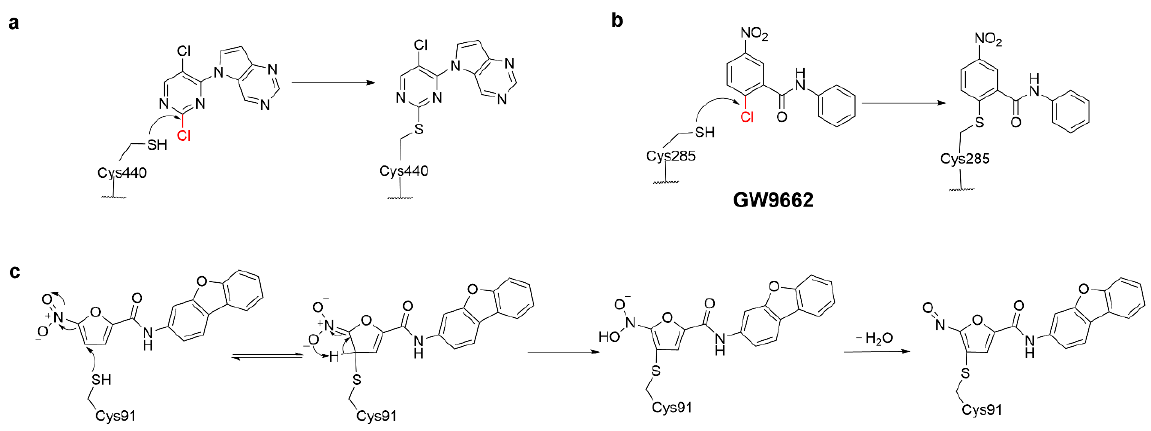
[31]. Moreover, 4 ‐ pyridylsulfide also underwent the S N Ar reaction with Cys249 at the ac ‐ tive site of dimethylarginine dimethylaminohydrolase (DDAH) (Figure 4c) [32].